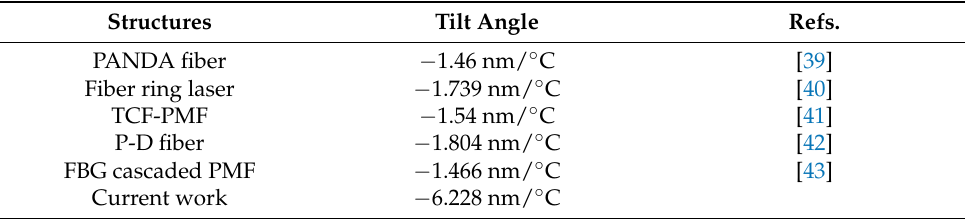
Table 1. The sensitivity comparation with other with other temperature sensors based on Sagnac